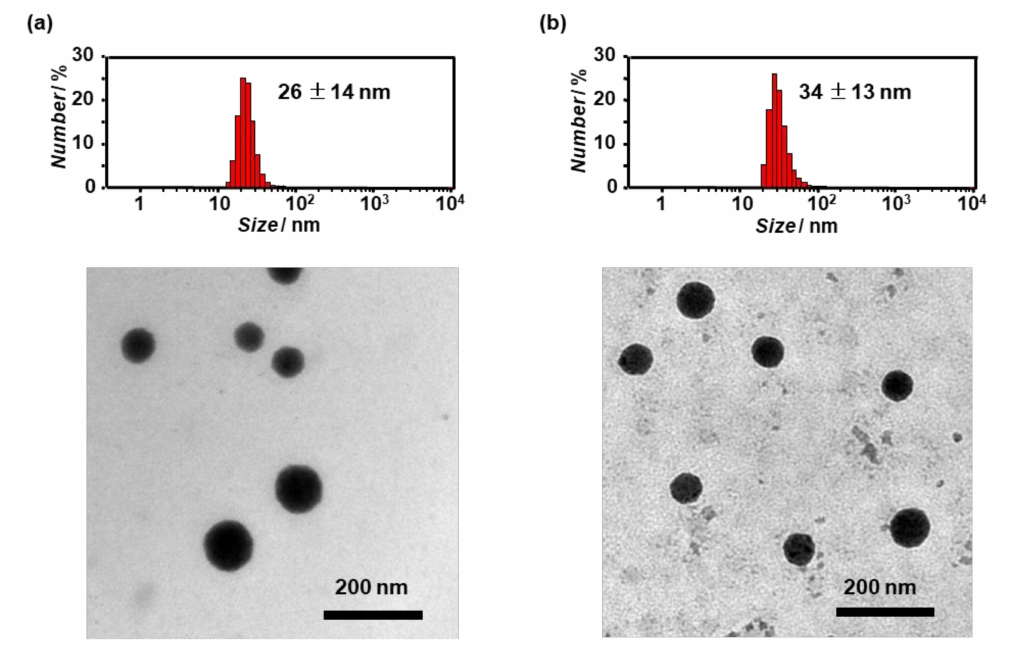
Figure 8. Size distributions obtained from DLS at 25 ◦ C and TEM images for solutions of ( a ) 50 µ M Ni-NTA modified β -annulus peptide and 50 µ M His-tagged HRP, ( b ) 25 µ M Ni-NTA modified β -annulus